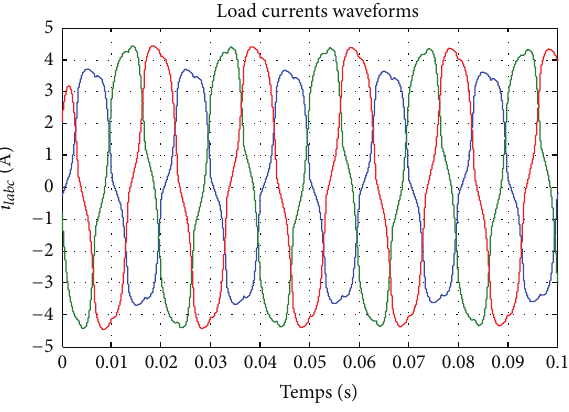
Figure 9: Total load currents